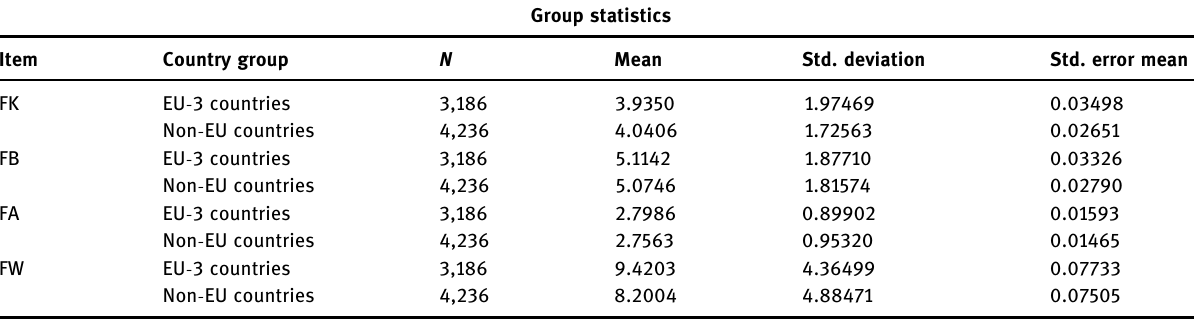
Group statistics